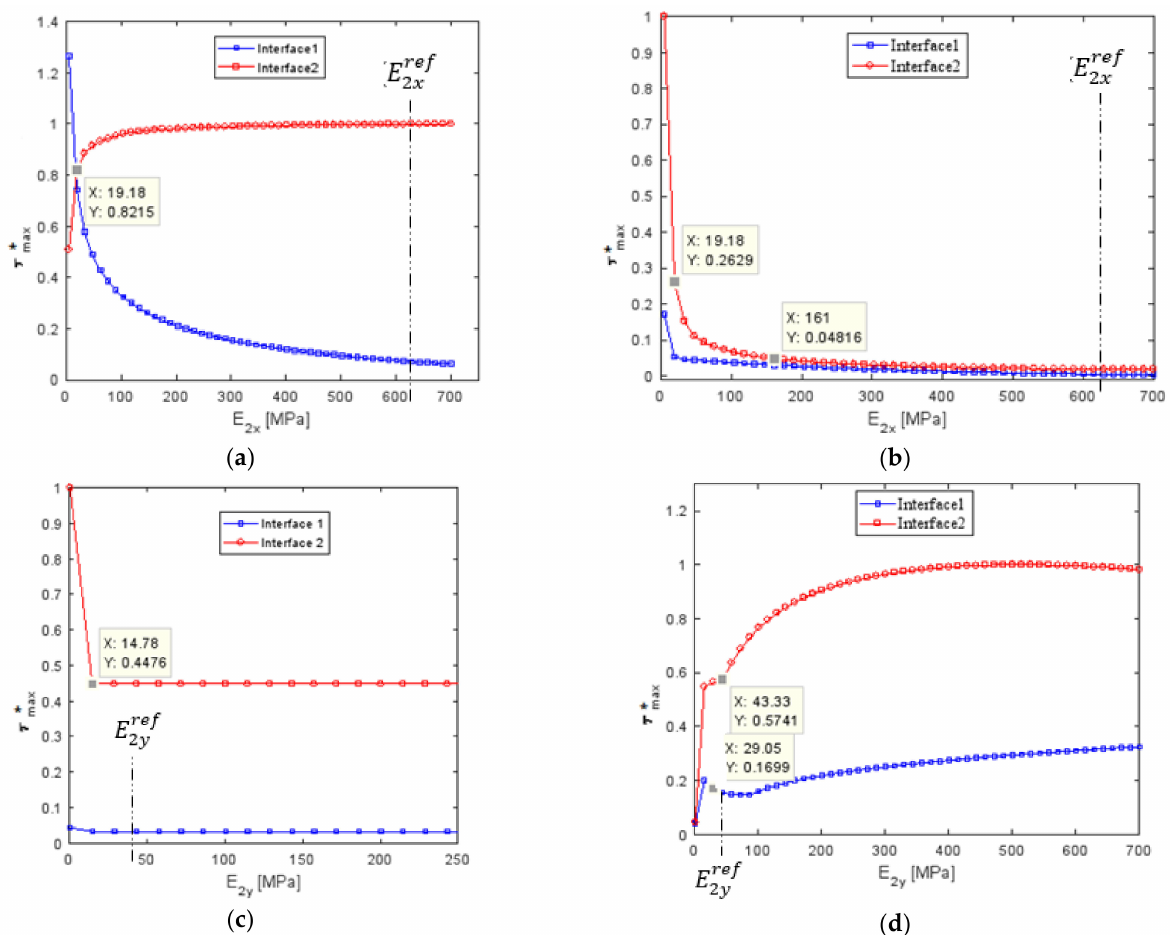
Figure 18. Variation of the maximal normalized shear stress in XZ-YZ plane as a function of: ( a , b ) longitudinal Young’s modulus; ( c , d ) transverse Young’s modulus.